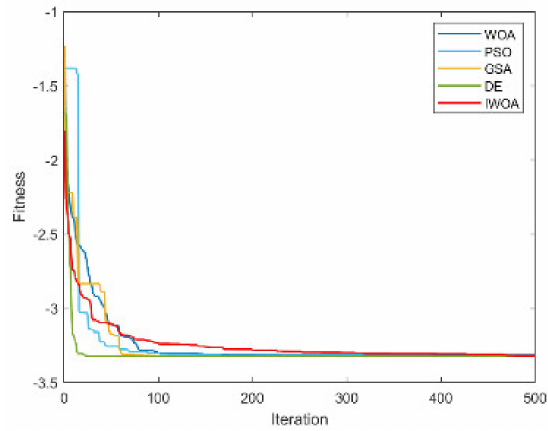
Figure A13. The convergence curve for solving F13.